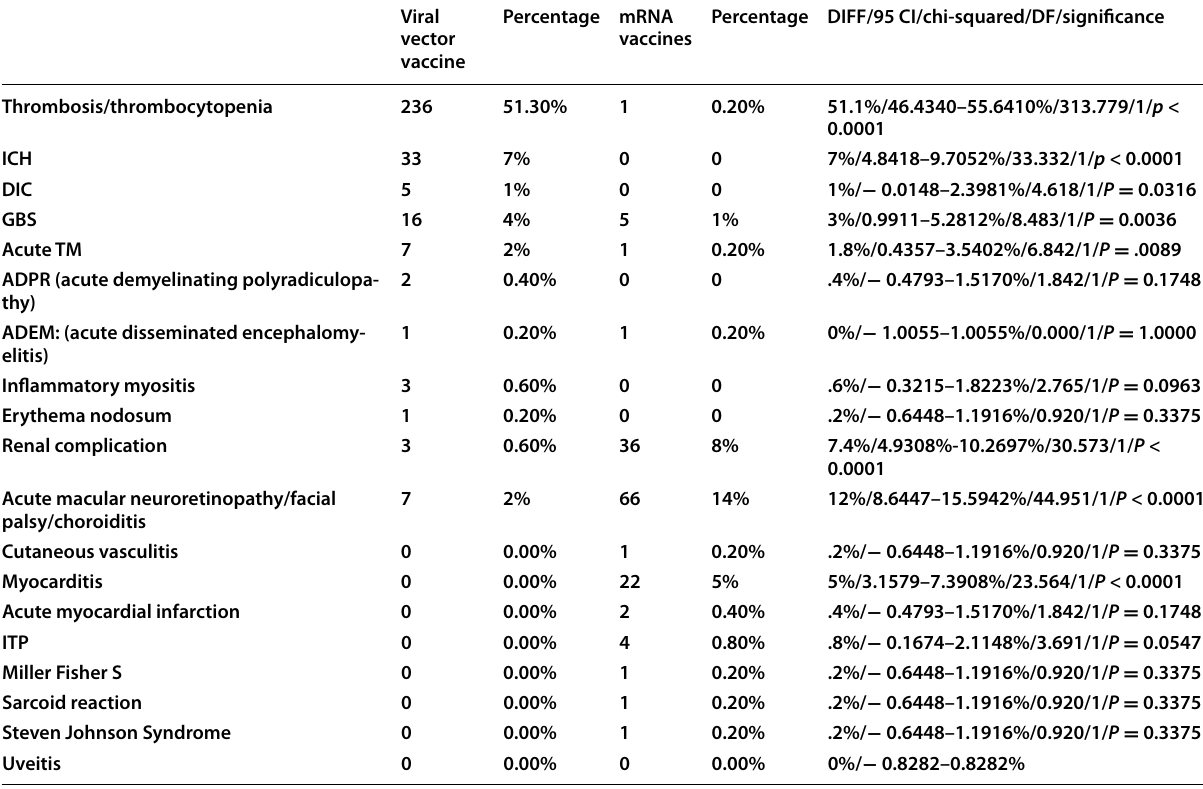
Table 2 Comparison between group 1 (pts received viral vector-based vaccines with adverse events) vs group 2 (pts received mRNA- based vaccines with adverse